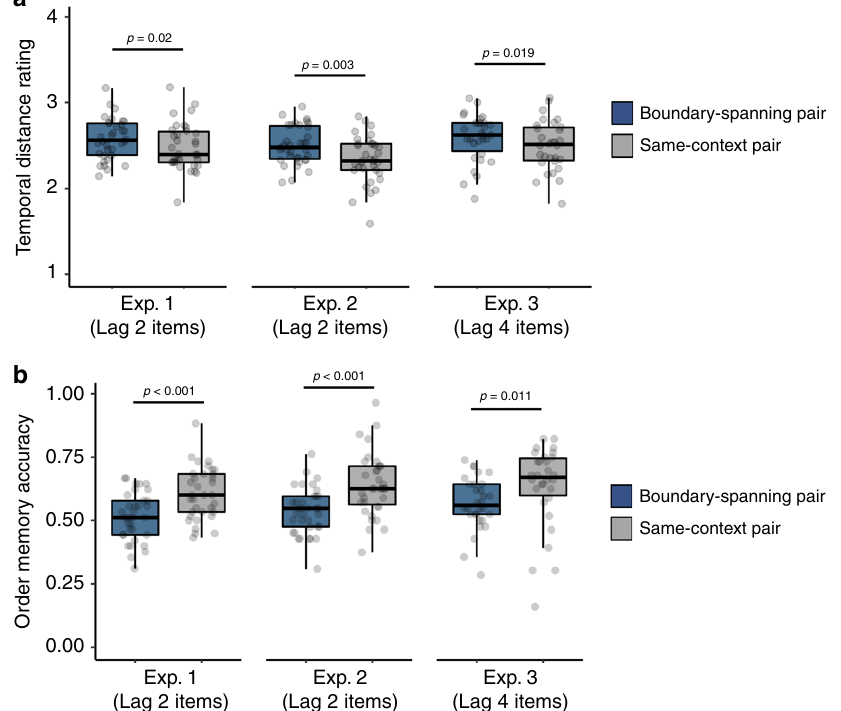
Fig. 3 Tone switches, or event boundaries, embedded within item sequences lead to impaired order memory and expanded retrospective estimates of temporal distance between item pairs spanning those boundaries. a Values represent average temporal distance ratings for item pairs from the object sequences. During this temporal memory test, participants rated how far apart the item pairs had appeared in the prior sequence, with choices ranging from ‘ very close ’ to ‘ very far ’ . The ratings were then converted to a scale ranging from 1 to 4 and averaged together, such that higher values on the y -axis re fl ect more expanded retrospective estimates of temporal distance between item pairs. b Values represent average temporal order memory accuracy for item pairs from the object sequences. During this temporal order memory test, participants had to decide which of two items had appeared later (i.e., more recently) in the previous sequence of images. ‘ Lag ’ refers to the number of intervening items that had appeared between the to-be-tested item pairs at encoding. For both panels, colored boxplots represent 25th – 75th percentiles of the data, the center line — the median, and the error bars — the s.e.m. Overlaid dots represent individual participants (Experiment 1: n = 34; Experiment 2: n = 35; Experiment 3: n = 30). Two-tailed paired t -tests were performed to test for signi fi cant differences between temporal memory outcomes for boundary pairs compared to same-context pairs. These t -tests were planned, so no adjustments were made for multiple comparisons. The results from the fi rst experiment were replicated in two follow-up experiments. Source data are provided as a Source Data fi